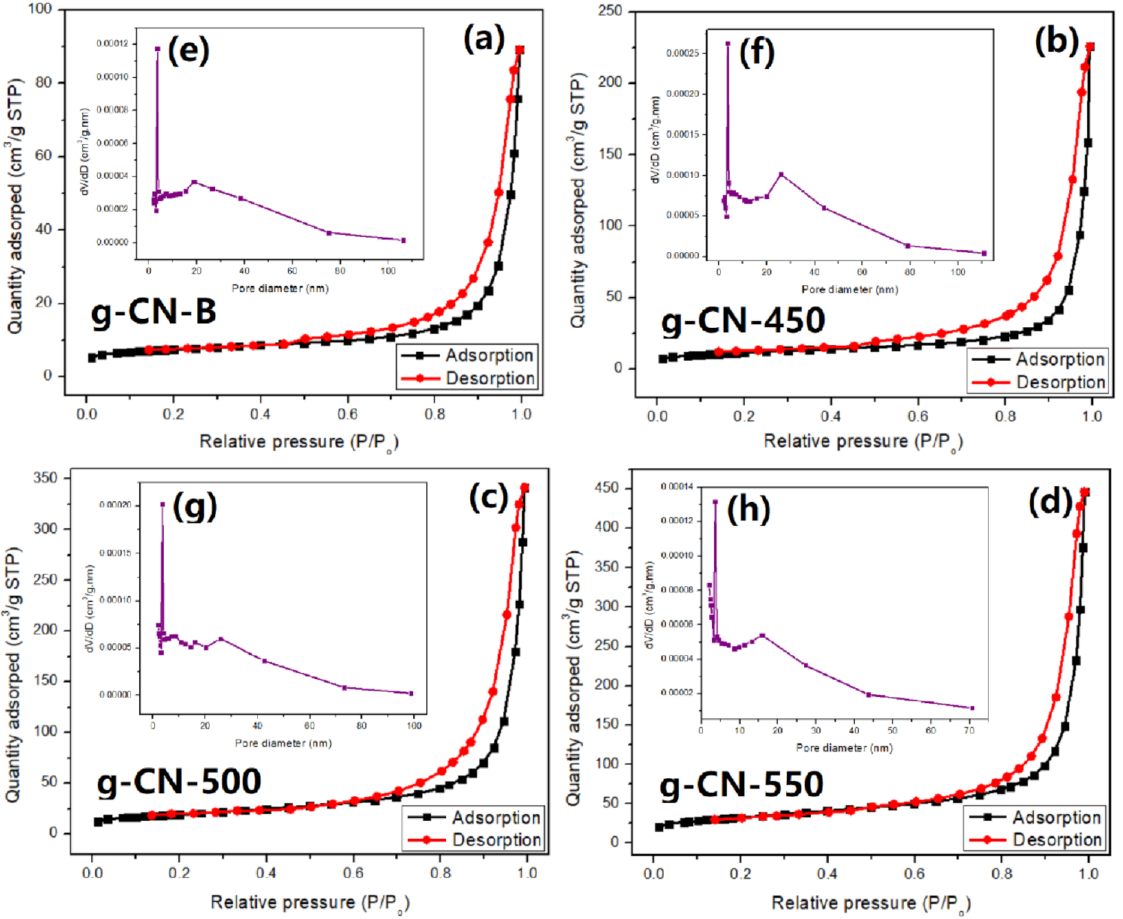
Figure 7. The N2 adsorption-desorption isotherms ( a ) GCN-B, ( b ) GCN-450, ( c ) GCN-500, ( d ) GCN-550, and the BJH pore size distributions of ( e ) GCN-B, ( f ) GCN-450, ( g ) GCN-500, ( h )